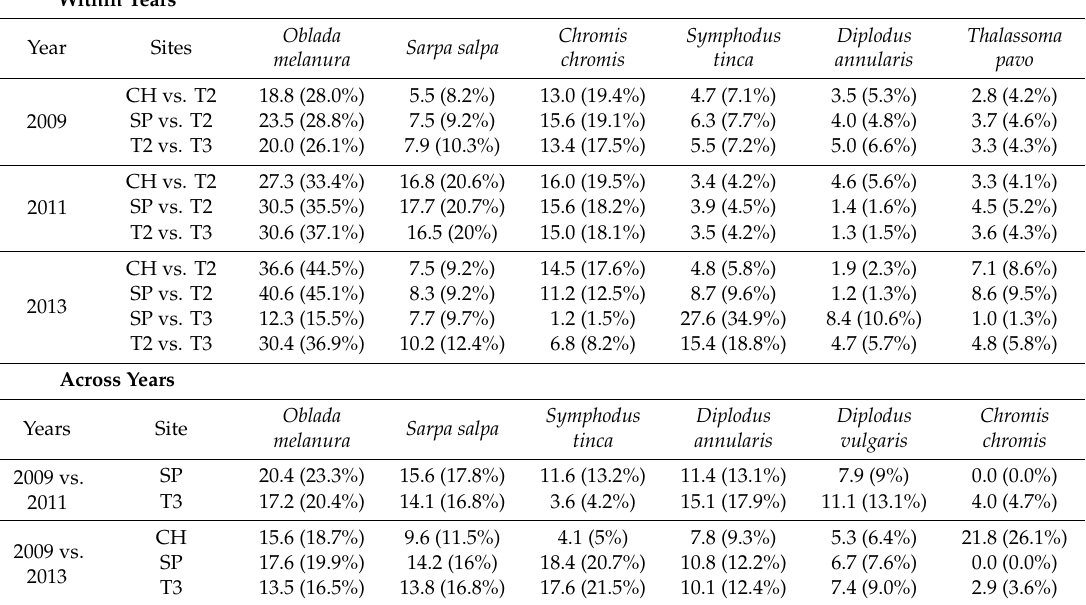
Table 5. Similarity Percentages (SIMPER) analysis results examining within-year and cross-year di ff erences in fish community composition among study sites ( Cabo de las Huertas —CH; Santa Pola —SP; Tabarca II—T2; Tabarca III—T3) for which significant di ff erences in composition were observed. Values presented as average dissimilarity and percent dissimilarity (in parentheses) for the top six contributing taxa per site